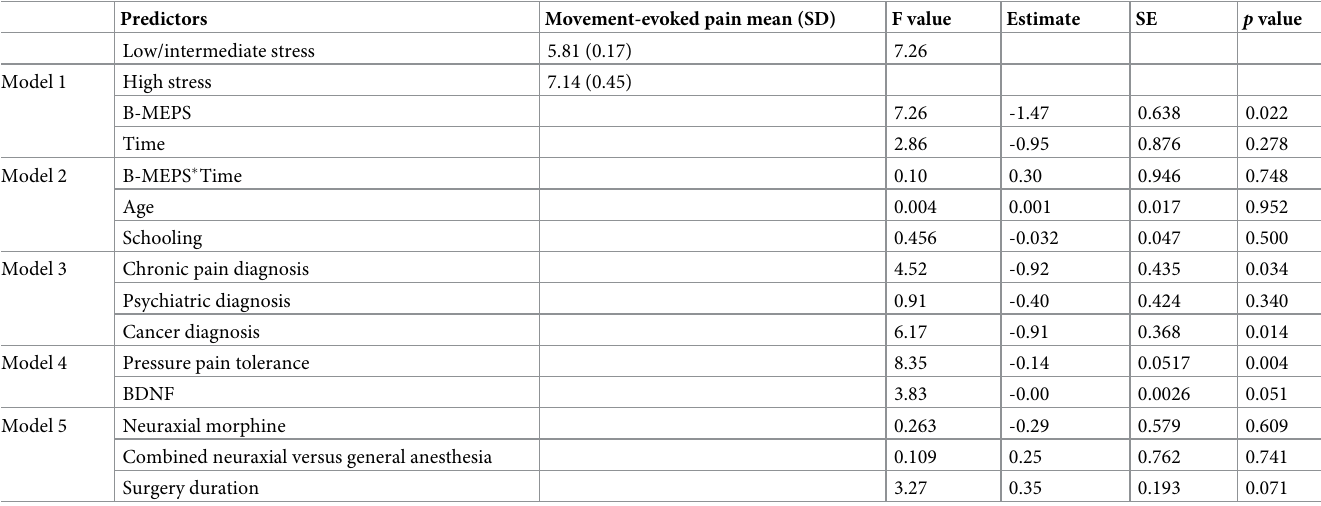
Table 6. Parameter estimates from repeated measures of Visual analogue scale for movement-evoked pain intensity using mixed model analysis. Predictors Movement-evoked pain mean (SD) F value Estimate